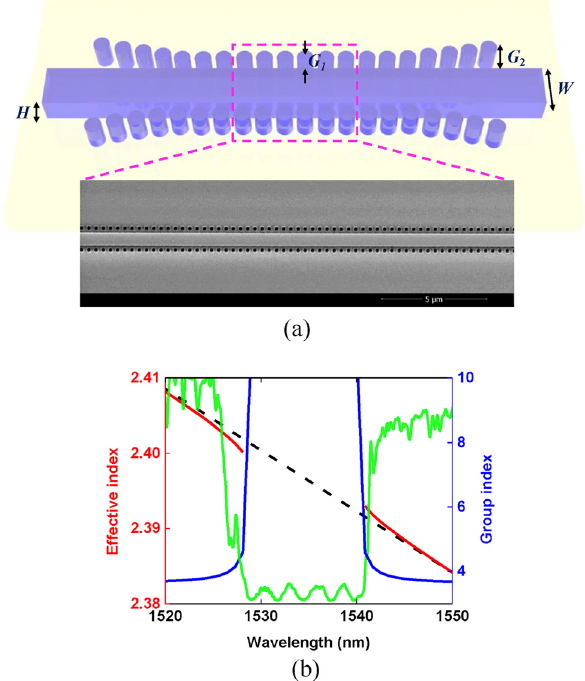
Figure 2: (a) The schematic and scanning electron micrograph of a fabricated CMBGs. (b) Group (blue line) and effective (red line) indices on wavelength near the band edges of the photonic bandgap.BlackdashedlinedepictseffectiveindexinUSRNWG.The light green line shows the linear transmission of the CMBGs with a 10 dB bandwidth of 12